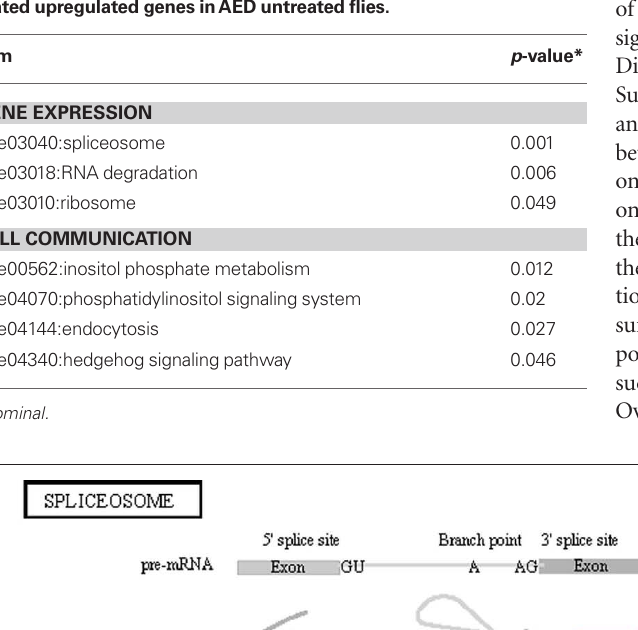
Figure 4 | genes mapping to Kegg pathway for spliceosome. Pink boxes represent upregulated genes in AED untreated flies. These genes are Hsp68 (Heat shock protein 68), U2af50 (U2 small nuclear riboprotein auxiliary factor 50),